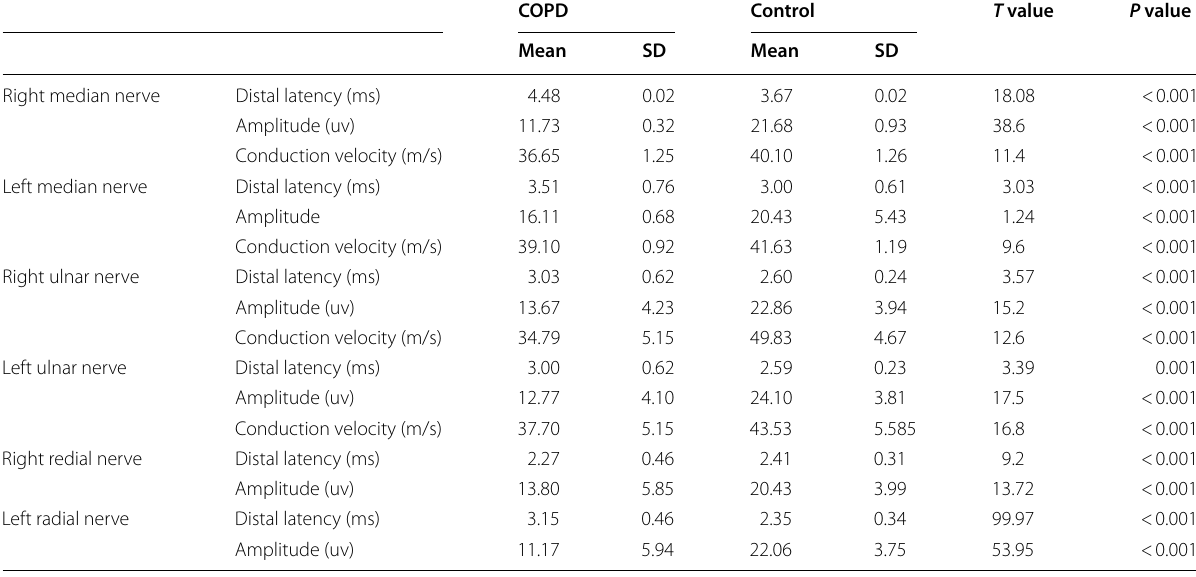
Table 4 Comparison between patient and control groups as regards to median, ulnar, and radial sensory nerve assessment COPD